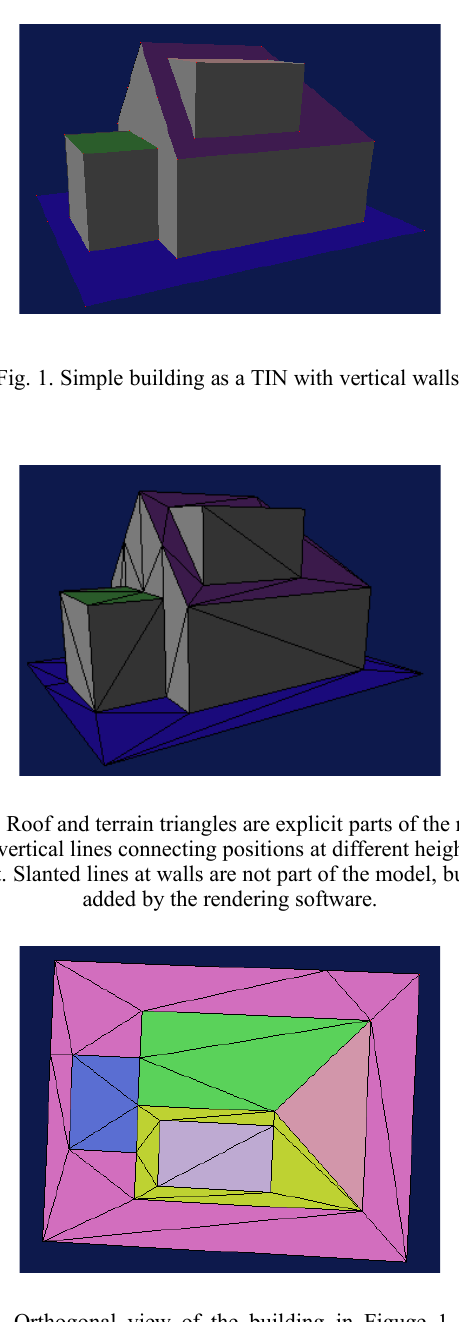
Fig. 3. Orthogonal view of the building in Figuge 1 and 2, showing polygons and triangles, and the fact that some ( x,y ) points (notably at the blue extension to the left) should occur at different